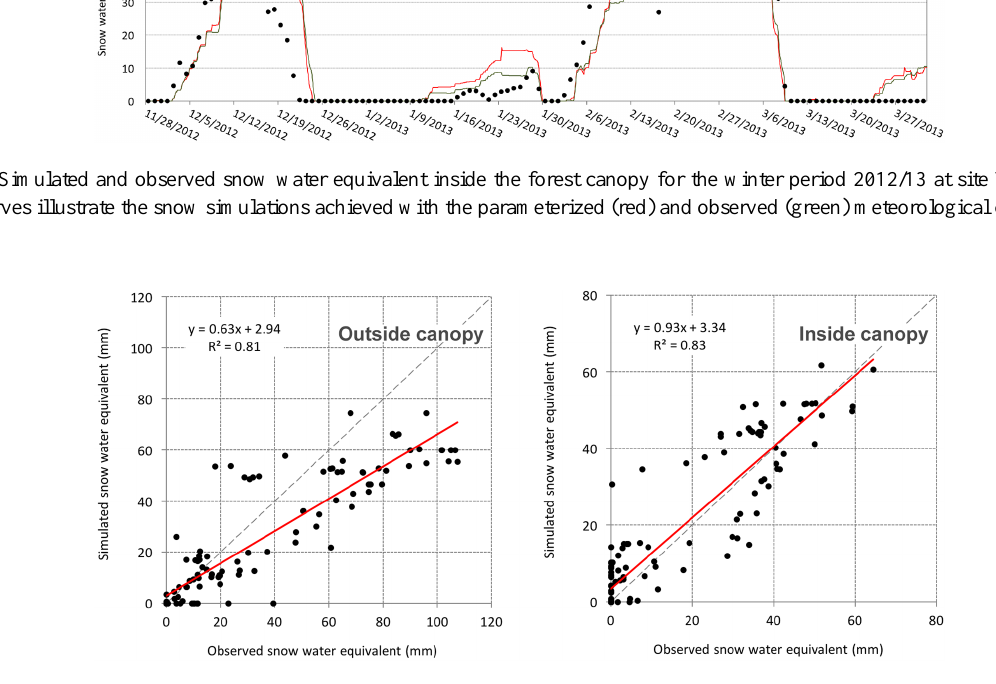
Figure 13. Snow water equivalent simulated with ESCIMO.spread (v2) vs. observed snow conditions outside and inside the forest canopy for the winter period 2012/13 at site